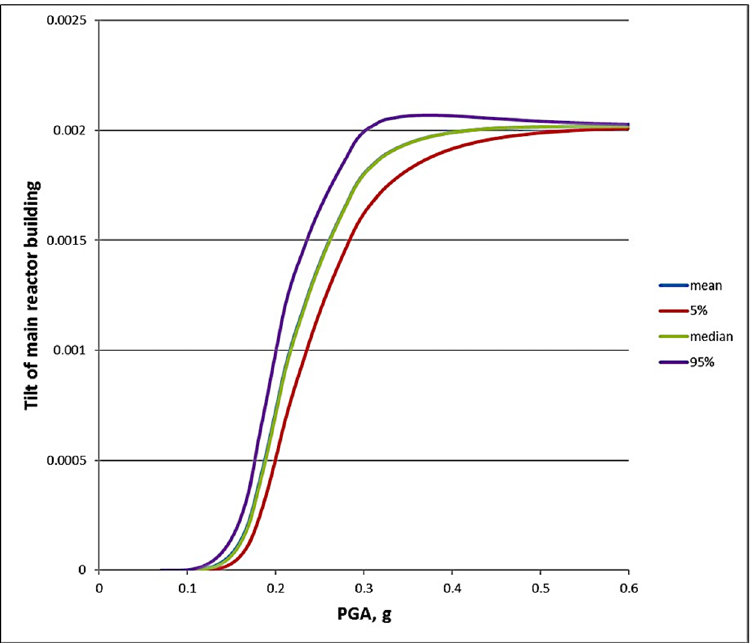
Figure 7. Tilt of the reactor building due to differential settlement versus peak ground accelera- tion.